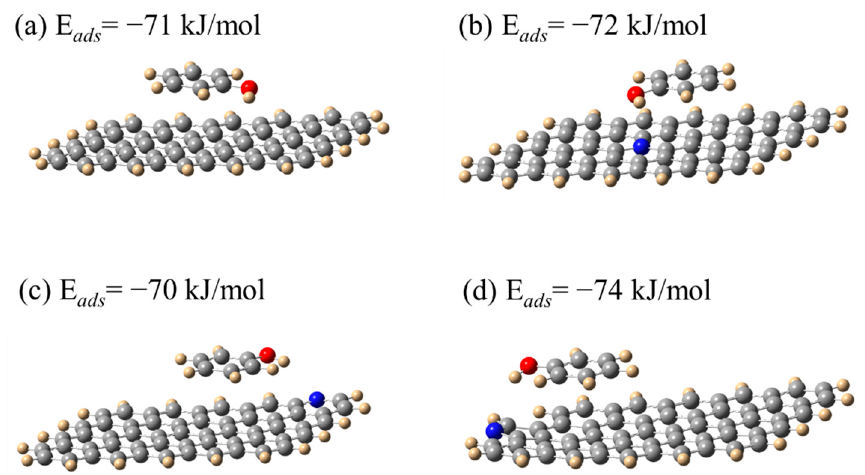
Figure 11. The optimized geometric structures of phenol adsorbed on N-free carbon ( a ), graphitic- N ( b ), pyridinic-N ( c ) and pyrrolic-N ( d ) functional groups.